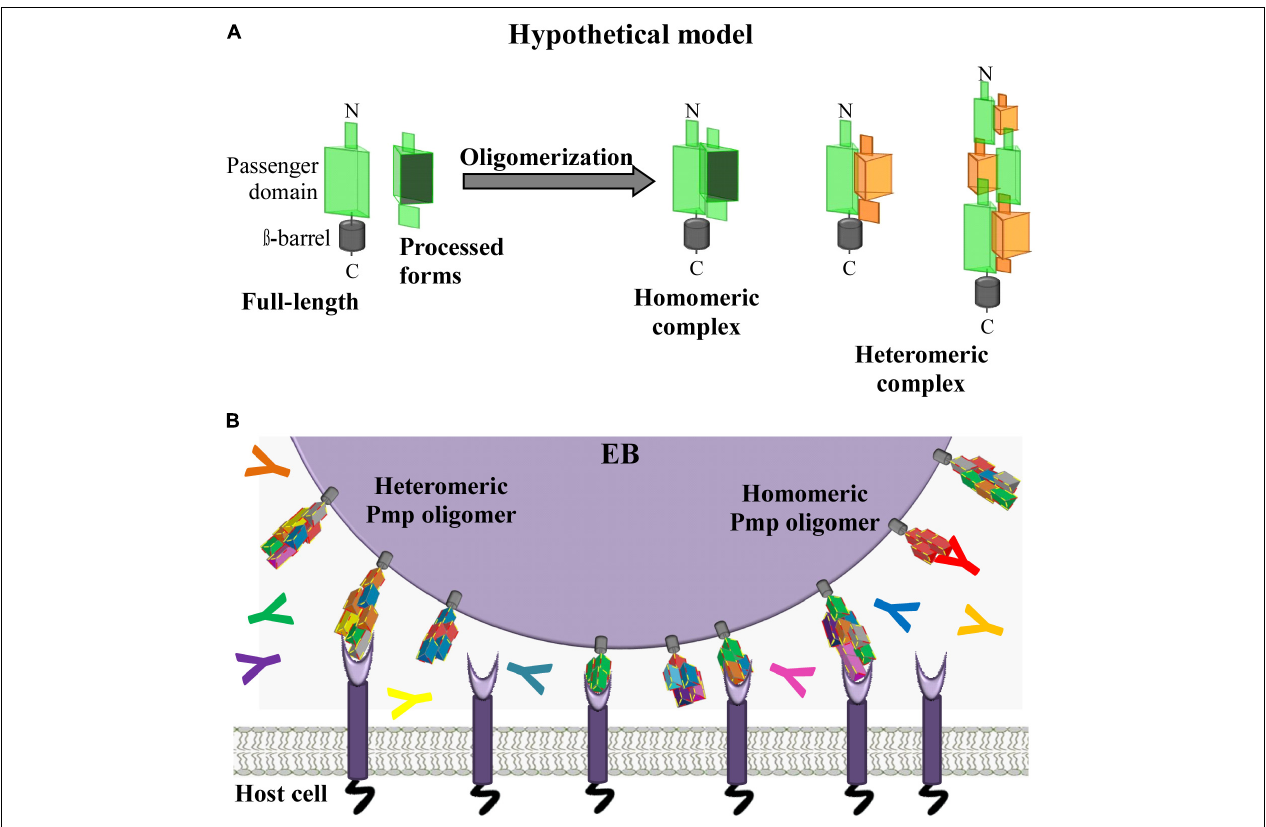
FIGURE 7 | Hypothetical model. C. trachomatis homomeric and heteromeric Pmp oligomers are relevant for infection. (A) Passenger domains (PD) of the different Pmps are exposed on the surface of the EBs either in full-length or as processed forms. Full-length and processed forms of the PD of the same or of different Pmps can interact with each other, potentially forming a variety of different homomeric and heteromeric elongated oligomers adapted from Hegemann and Moelleken, 2012. (B) In vivo C. trachomatis homomeric and heteromeric Pmp structures may differ on individual infectious EBs; however, based on the adhesive capacity of their subunit Pmps, Pmp oligomers may facilitate adhesion to human cells by binding to unknown receptor(s), thus supporting EB host cell entry. Pmp-specific antibodies (coloured Y symbols) may or may not bind and block Pmp proteins, as recognition might depend on composition of the homomeric or heteromeric Pmp